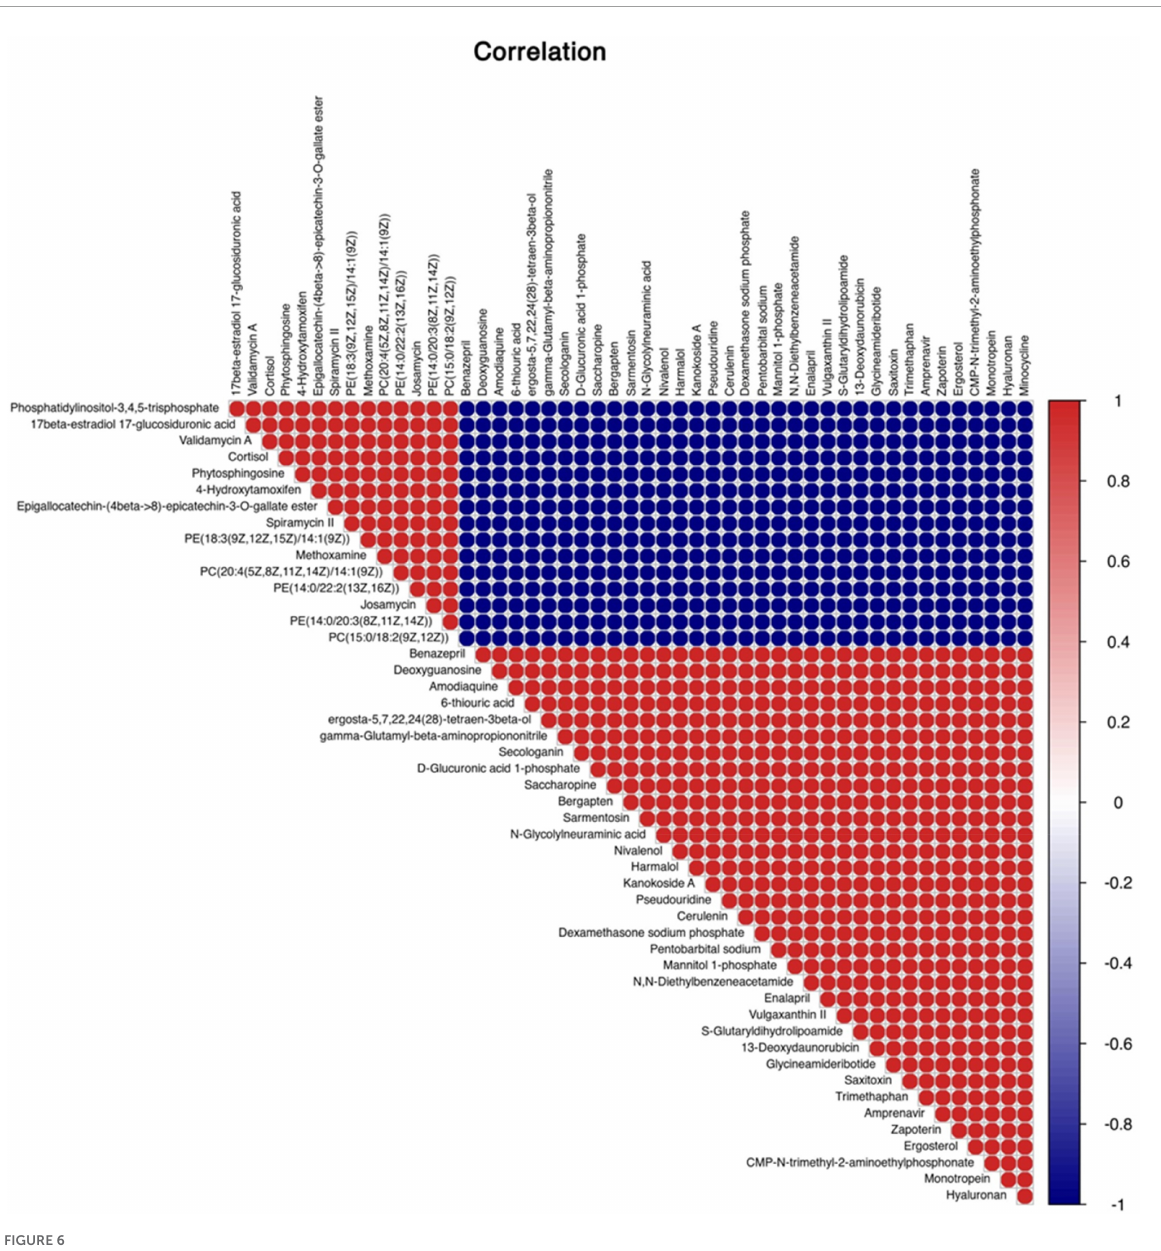
FIGURE6 Correlation analysis between differential metabolites of A26 and B30 strains.